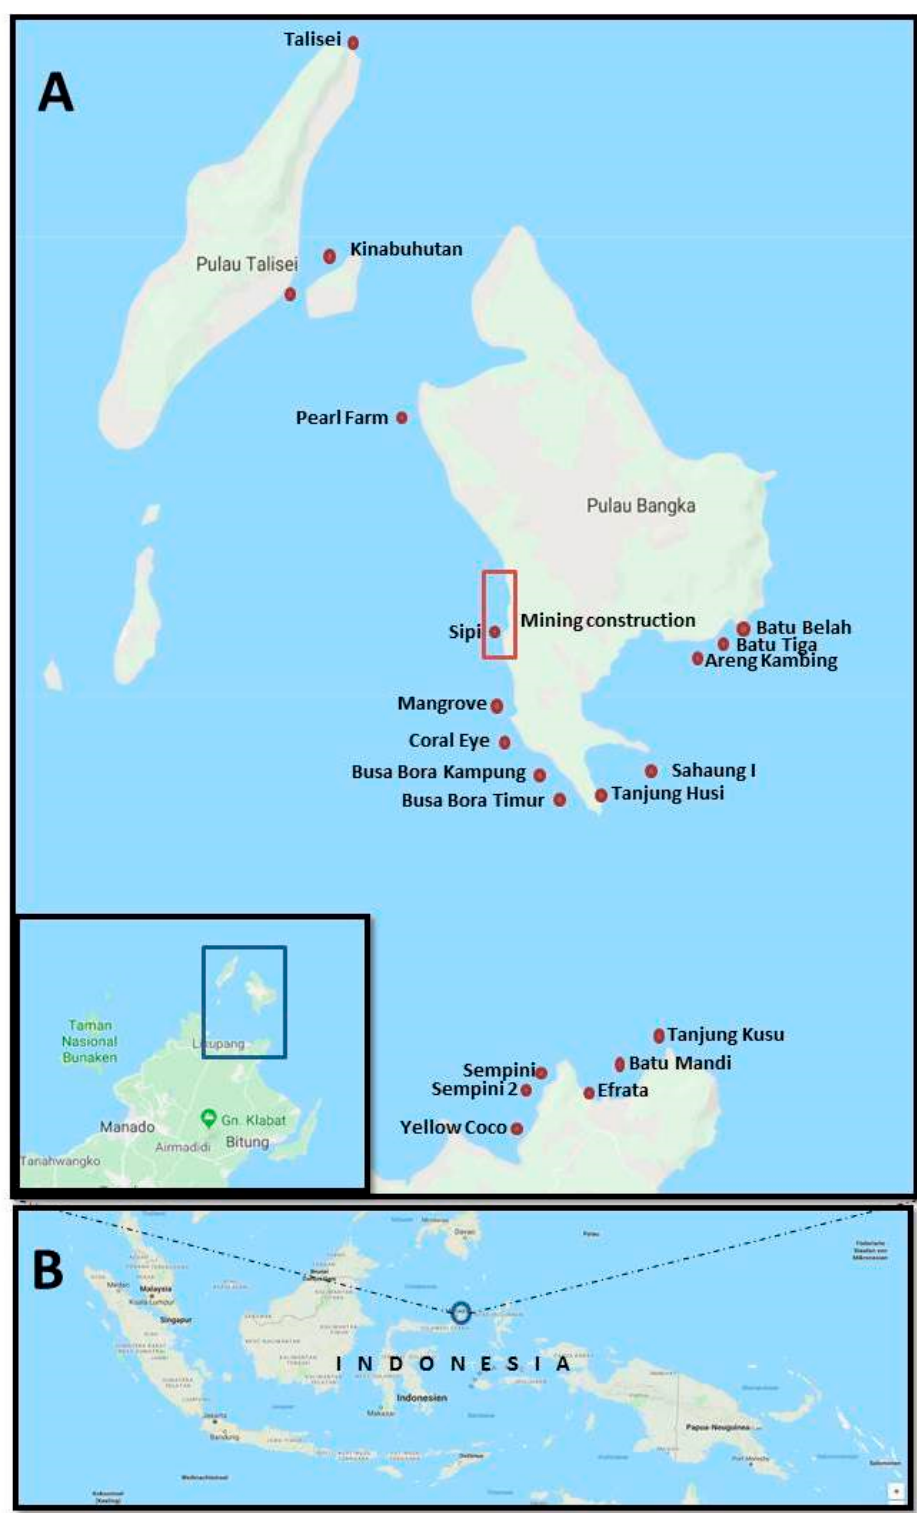
Figure 1. Location of the study area: ( A ) depiction of the 19 diving sites at Bangka Archipelago and mainland. Insert showing the region of North Sulawesi with Bangka Archipelago. ( B ) Indonesia and Sulawesi, with the blue circle indicating the close-up area in A.